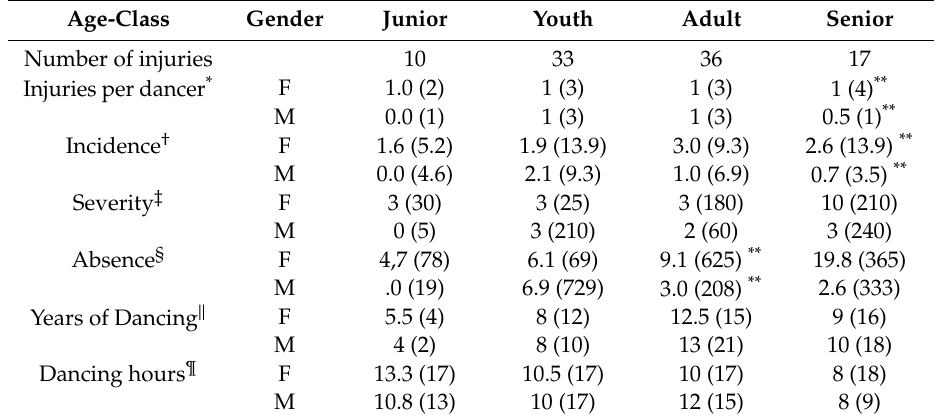
Table 2. Incidence and severity of injuries in the last 12 months between gender and age-class.